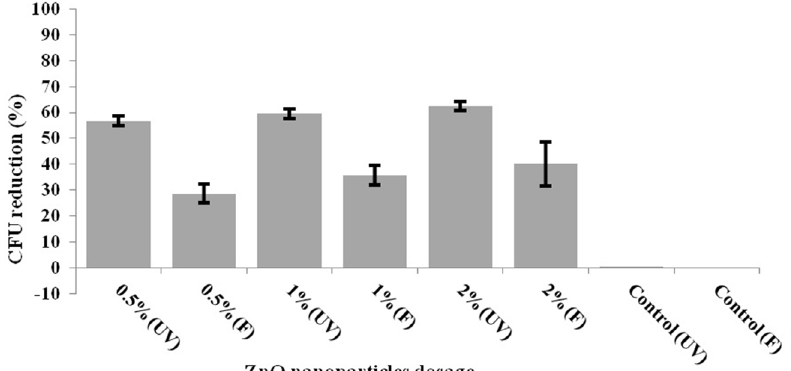
Fig. 5. Bactericidal effects of ZnO NPLs loaded LDPE films on S. aureus in fresh calf minced meat after 72 hr in the presence of fluorescent and UV lights at 4 o